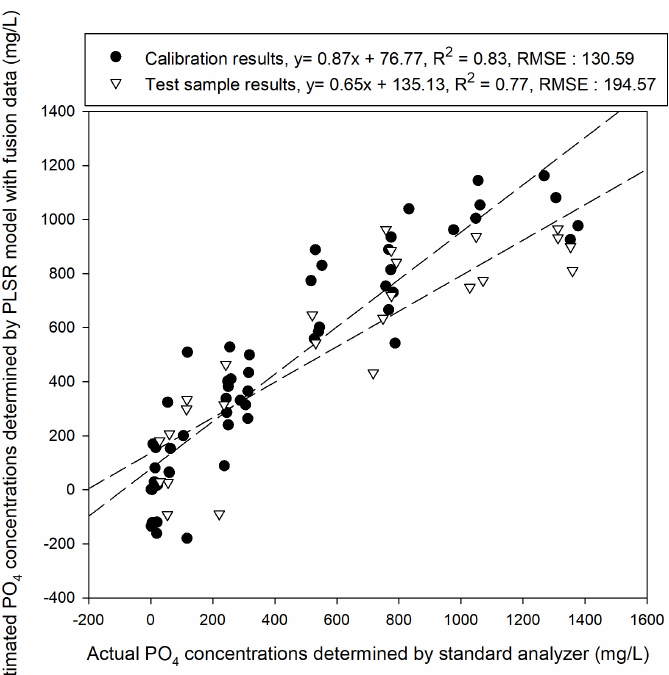
Figure 10. Calibration and test sample prediction results with PLSR analysis performed using the combined data.